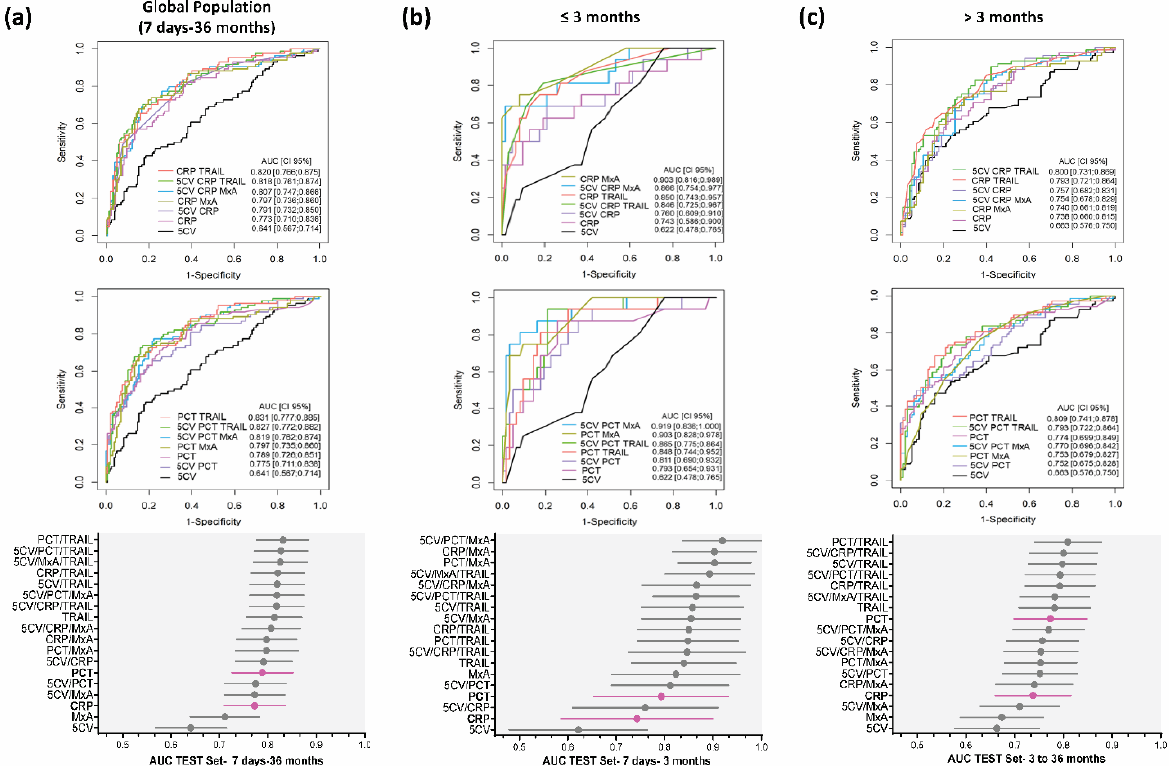
Figure 3. Performance of models combining biomarkers and clinical variables using machine learning (TEST set). ROC curves and forest plots of best performing models are shown for the global population ( a ), the ≤ 3-month-old patients ( b ), and the >3-month-old patients ( c ). The upper ROC curves show the comparisons to CRP (pink curves) and the lower ROC curves the comparisons to PCT (pink curves). The clinical variables alone (5CV) are shown as black curves. The forest plots depict AUC (plain circles) and respective 95% CI (horizontal whiskers). Complete performance results are shown in Table S7. In terms of AUC, PCT/TRAIL performed best in the global population, with an AUC of 0.831. The difference in AUC between PCT/TRAIL and PCT (AUC = 0.789) was close to statistically significant ( p = 0.056), while that between PCT/TRAIL and CRP (AUC = 0.773) was statistically significant ( p = 0.025). In the ≤ 3-month-old group, the best model in respect of both AUC and LR was 5CV/PCT/MxA (AUC = 0.919, LR+ = 21.31, LR − = 0.32). The differences in AUC between 5CV/PCT/MxA and PCT (AUC = 0.793) and between 5CV/PCT/MxA and CRP (AUC = 0.743) were both statistically significant ( p = 0.030 and p = 0.005,